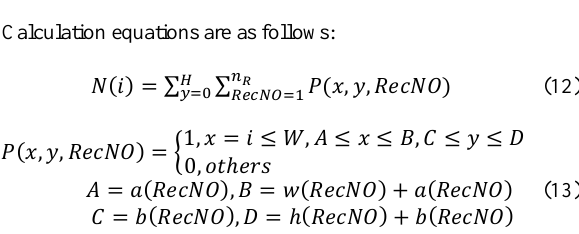
N(i) represents the value of vertical axis when abscissa equals i in the histogram; 𝑛 𝑅 represents the number of rectangular detection; RecNO is the index number of rectangular detection. 𝑤(𝑅𝑒𝑐𝑁𝑂) and 𝑎(𝑅𝑒𝑐𝑁𝑂) are the height of rectangular detection with serial number RecNO and y coordinate values of left top angular point respectively; W and H are the width and height of the image respectively. The detection intensity histogram is mapped in Figure